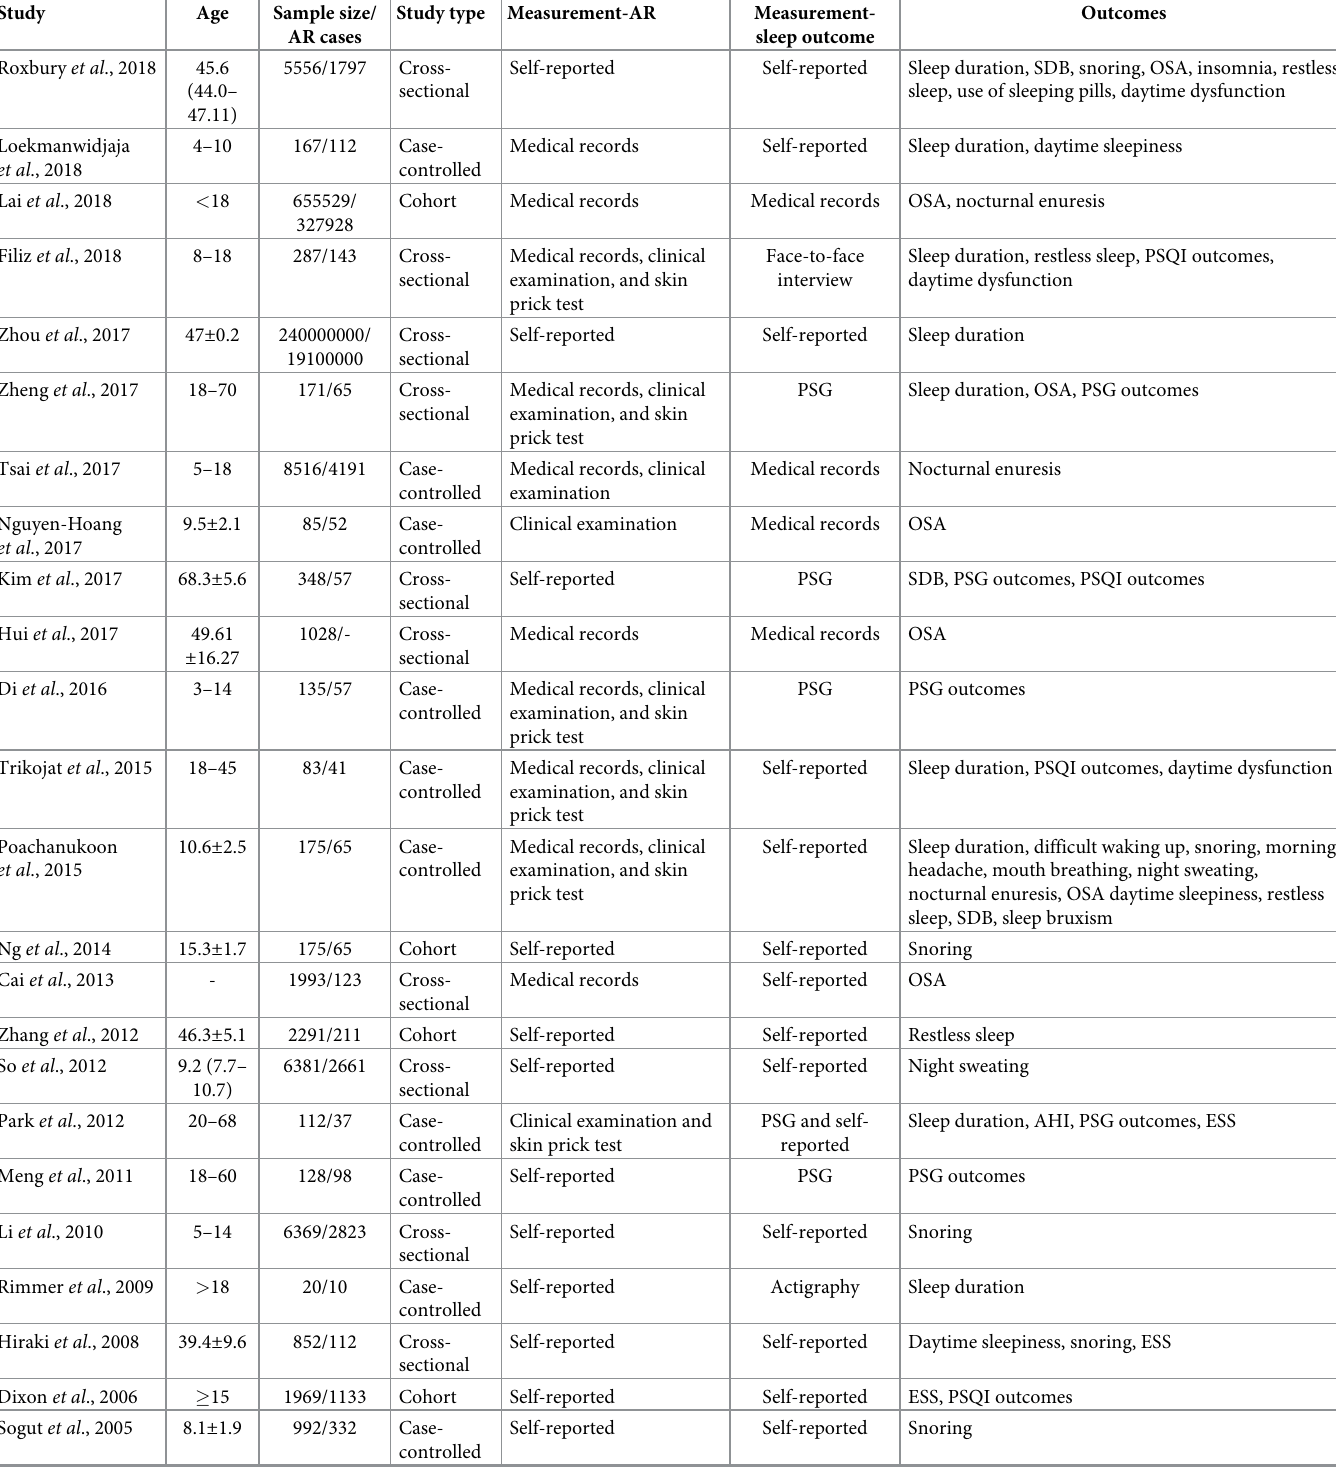
Table 1. Characteristics of included